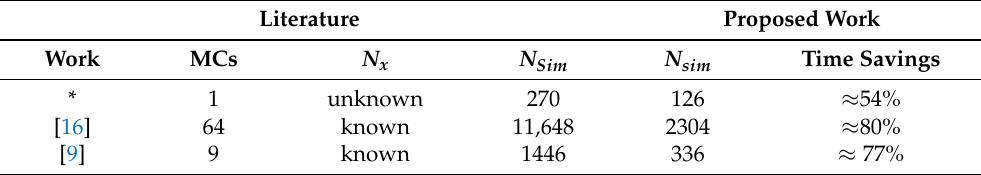
Table 6. Benefits of the proposed fitting approach in the existing literature. Literature Proposed Work